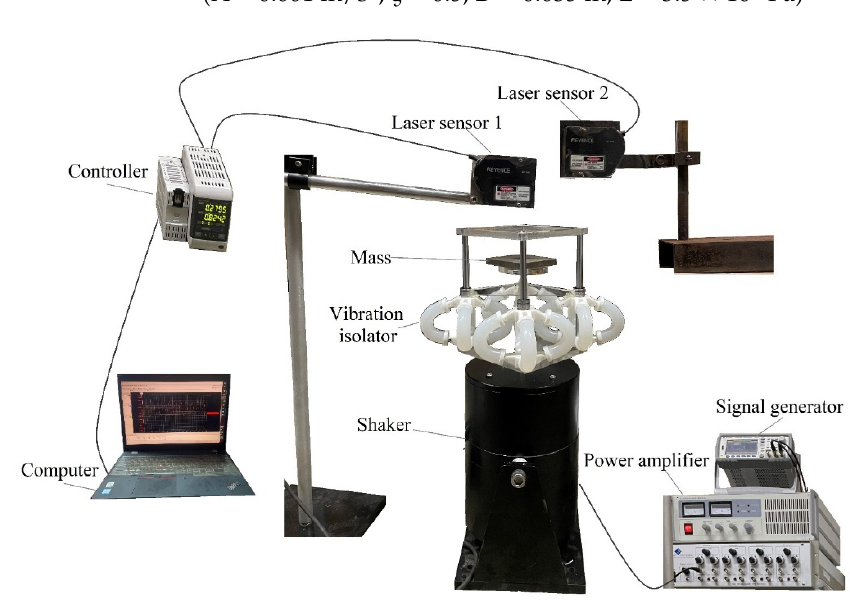
Figure 11. Experimental set-up for the vibration isolation test.